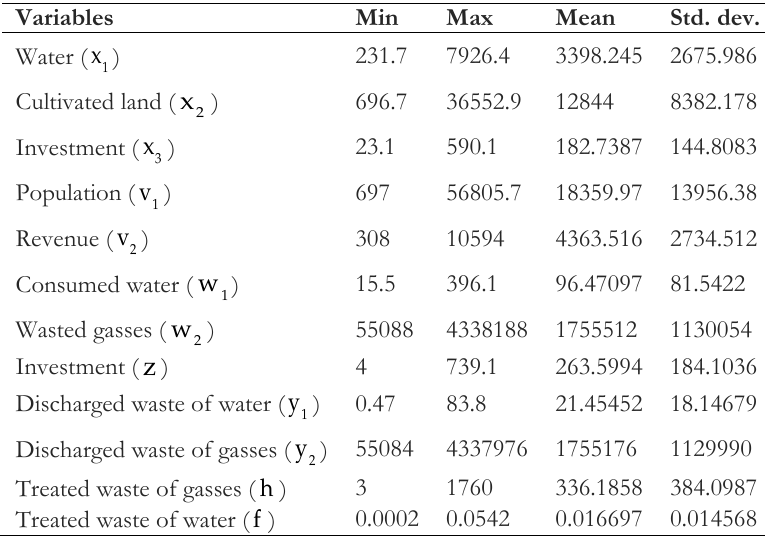
Table 1. Stutistical summary for variables of 31